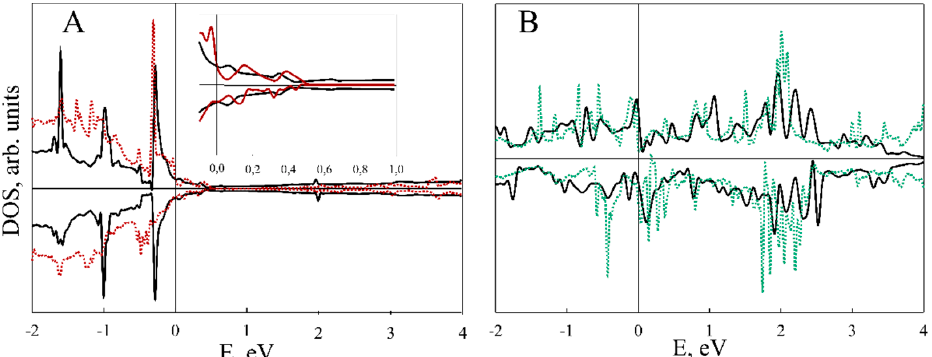
Figure 6. DOS for V 4 P 4 /ZnO composite. ( A ) Black and red lines correspond to TDOS of pristine ZnO slab and PDOS of ZnO fragment in V 4 P 4 /ZnO composite; ( B ) black and green lines correspond to TDOS of pristine V 4 P 4 slab and PDOS of VP in the composite structure, respectively.